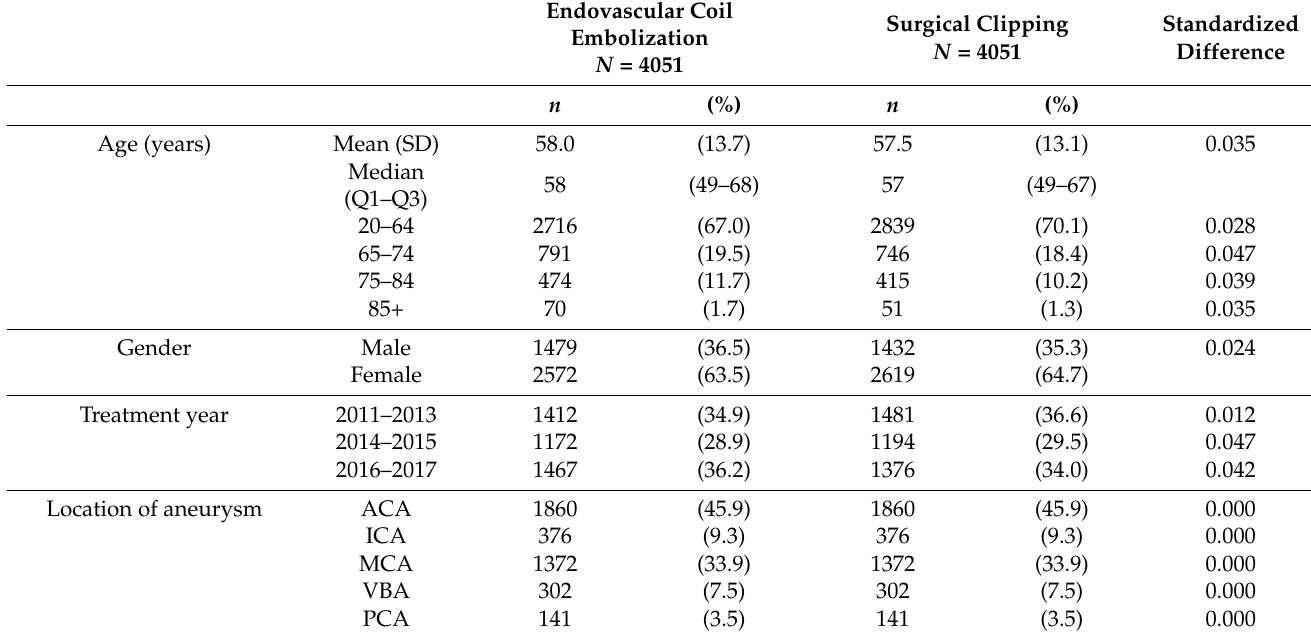
Table 1. Demographic and clinical parameters of propensity score–matched patients with ruptured intracranial